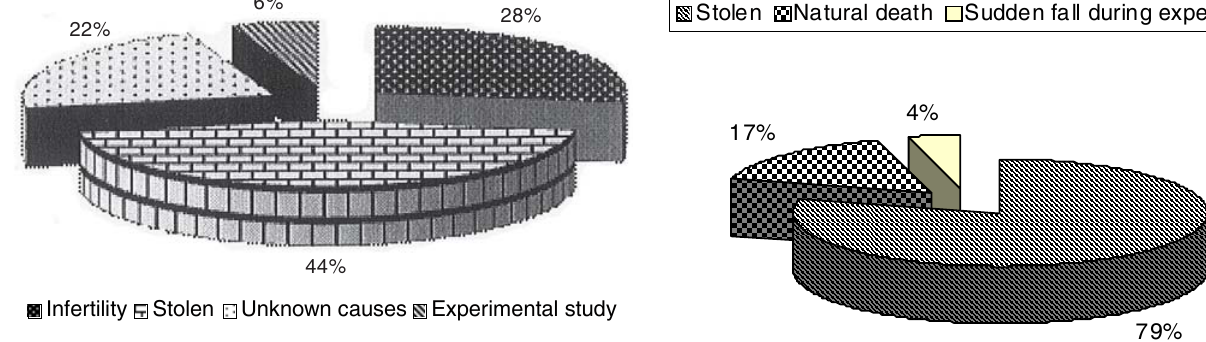
Figure 3. Loss of